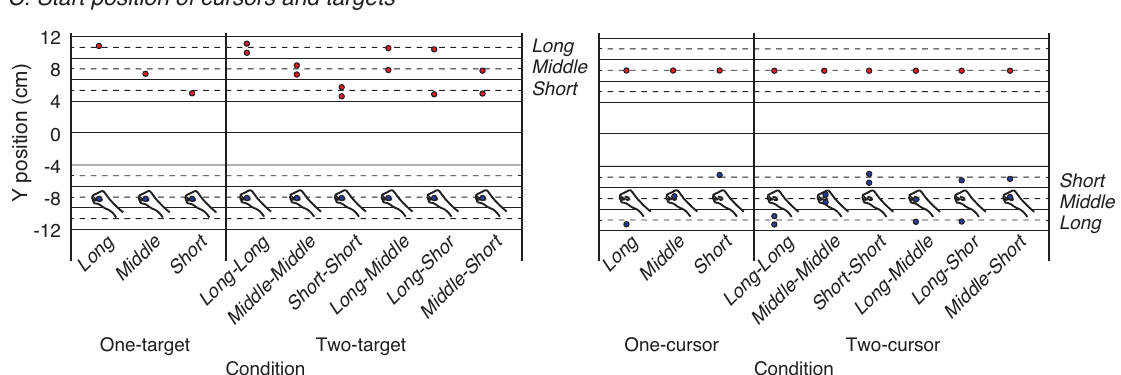
Fig 1. Experimental setting. (A) Originality in the current study. (B) Experimental task. The study used four conditions for the initial state of cursor and target: the two-target condition, the two-cursor condition, the one-target condition, and the one-cursor condition. In the two- target condition, at the beginning of the task, a cursor and two potential targets were presented along a vertical line. In this condition, after movement onset, one of the two targets disappeared, and the other remained at the initial position. The participants were required to reach and keep the cursor on the remaining target within a time constraint (500 or 750 ms in the fast and slow groups, respectively). In the